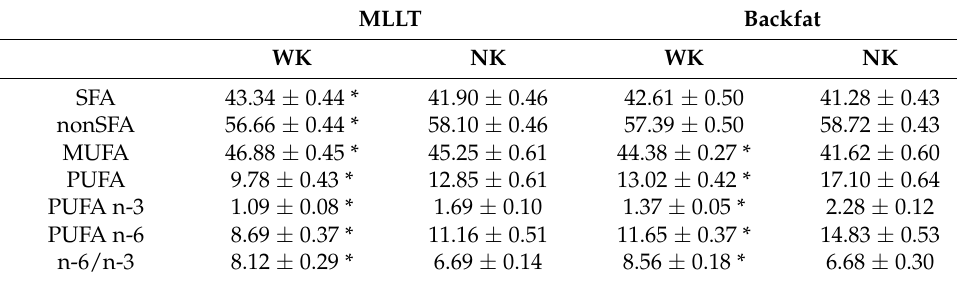
Table 2. The composition of fatty acids in the intramuscular fat of musculus longissimus lumborum et thoracic (MLLT) and in the depot fat of pigs. The significant difference between the experimental group of pigs (WK) and the control group of pigs (NK) marked by an asterisk. (Means ± SEM g 100 g − 1 ). MLLT